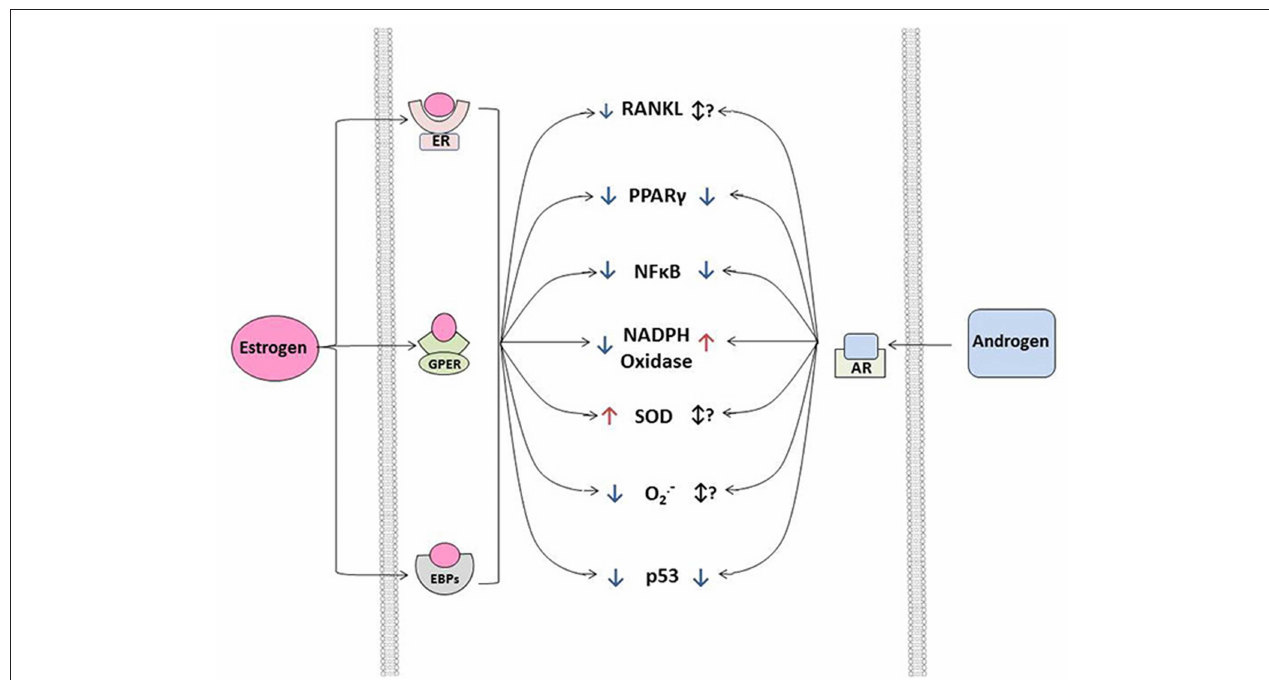
FIGURE 2 | Interactions between estrogen signaling, androgen signaling, and osteogenic signaling in vascular smooth muscle or aortic valve interstitial cells exposed to physiological levels of sex hormones. Note that—in general—both estrogens and androgens suppress osteogenic signaling via both genomic and non-genomic mechanisms in both cell types at physiological levels in relatively early to mid-life stages. Importantly, the therapeutic harnessing of these mechanisms requires substantial research into the context dependence of sex hormone signaling (e.g., timing relative to menopause, level to which hormones should be restored for optimal therapeutic benefit, etc.). TGF- β , transforming growth factor β ; BMP, bone morphogenetic protein; Wnt, wingless-related integration site; TGF β R1/2, transforming growth factor beta receptor 1 or 2; BMPR1/2, bone morphogenetic protein receptor 1 or 2; Nox4, NADPH oxidase 4; SARA, smad anchor for receptor activation; Smad, Suppressor of Mothers Against Decapentaplegic; LRP5/6, Low-density lipoprotein receptor-related protein 5 or 6; CK1, Casein kinase 1; DVL, Disheveled protein; Axin, Axin 1 protein; APC, adenomatous polyposis coli protein; GSK3, Glycogen synthase kinase 3; CTTN β , beta-catenin protein; TCF 4/7, Transcription factor 4 or 7; LEF1, Lymphoid Enhancer Binding Factor 1; FZD, Frizzled